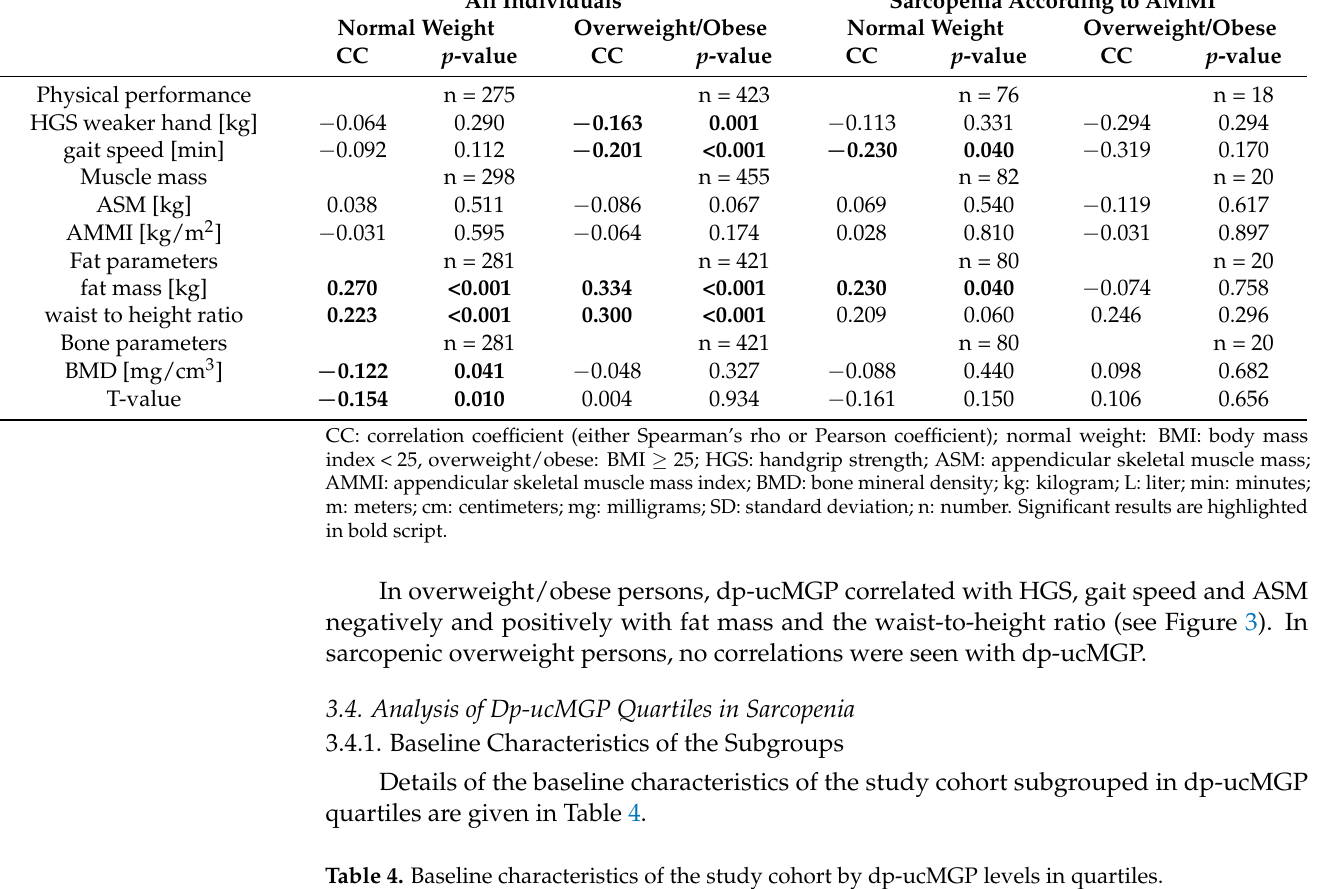
Table 4. Baseline characteristics of the study cohort by dp-ucMGP levels in